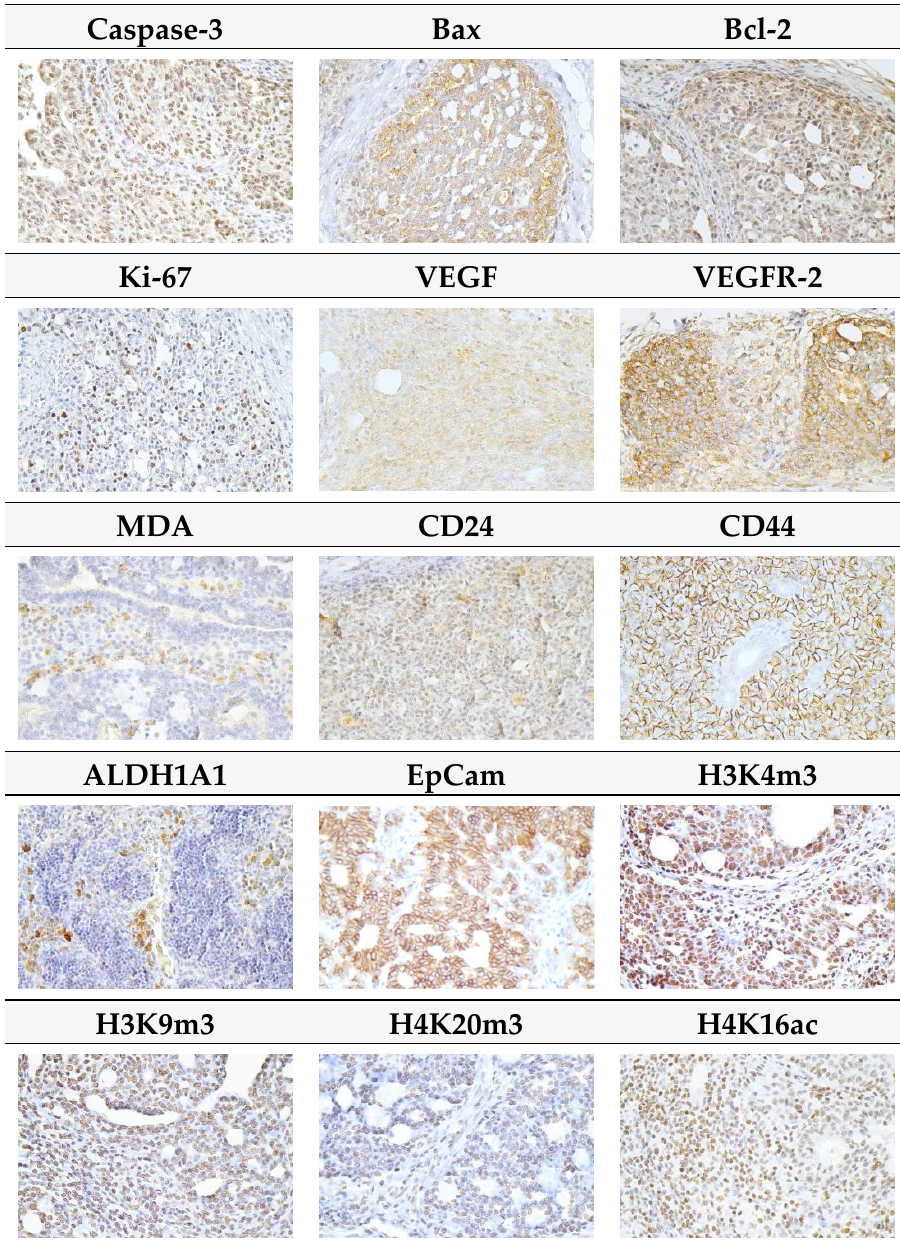
Figure 5. Representative images of expression of caspase-3, Bax, Bcl-2, Ki67, VEGFA, VEGFR-2, MDA, CD24, CD44, ALDH1A1, EpCam, H3K4m3, H3K9m3, H4K20m3, and H4K16ac in rat mammary carcinoma cells. For detection, polyclonal caspase-3 antibody (Bioss, Woburn, MA, USA), polyclonal Bax and Bcl-2 antibodies (Santa Cruz Biotechnology, Paso Robles, CA, USA), monoclonal Ki67 antibody (Dako, Glostrup, Denmark), monoclonal VEGFA and VEGFR-2 antibodies (Santa Cruz Biotechnology, Paso Robles, CA, USA), polyclonal CD24 antibody (GeneTex, Irvine, CA, USA), polyclonal CD44 antibody (Boster, Pleasanton, CA, USA), polyclonal ALDH1A1 antibody (ThermoFisher, Rockford, IL, USA), polyclonal MDA, EpCAM, H3K4m, H3K9m3, and H4K20m3 antibodies (Abcam, Cambridge, MA, USA) and monoclonal H4K16ac antibody (Abcam, Cambridge, MA, USA) were used; final magnifications: ×400.